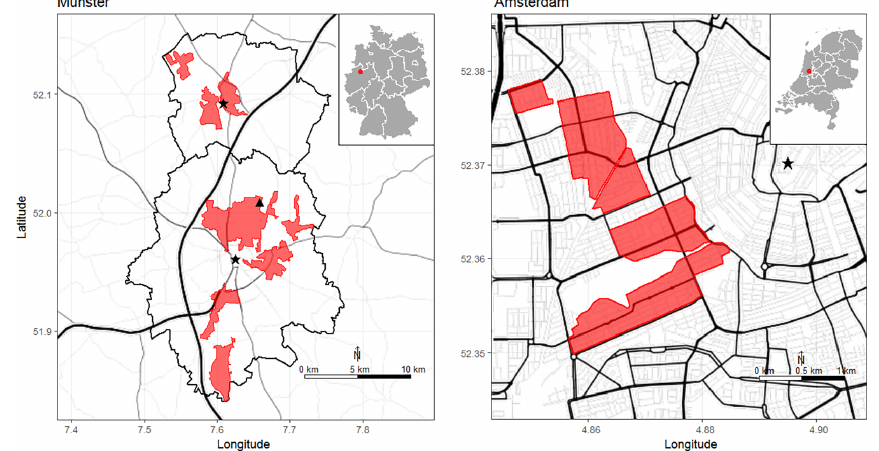
Figure 2. Overview map of the two case study areas. The left panel shows the cities of Münster (bottom) and Greven (top). The black triangle shows the location of the gauge “Hauptkläranlage” in Münster. The right panel shows the neighbourhoods Oud-West and Oud-Zuid in Amsterdam. Sample areas are shown in red. The black stars indicate the centres of the three cities.